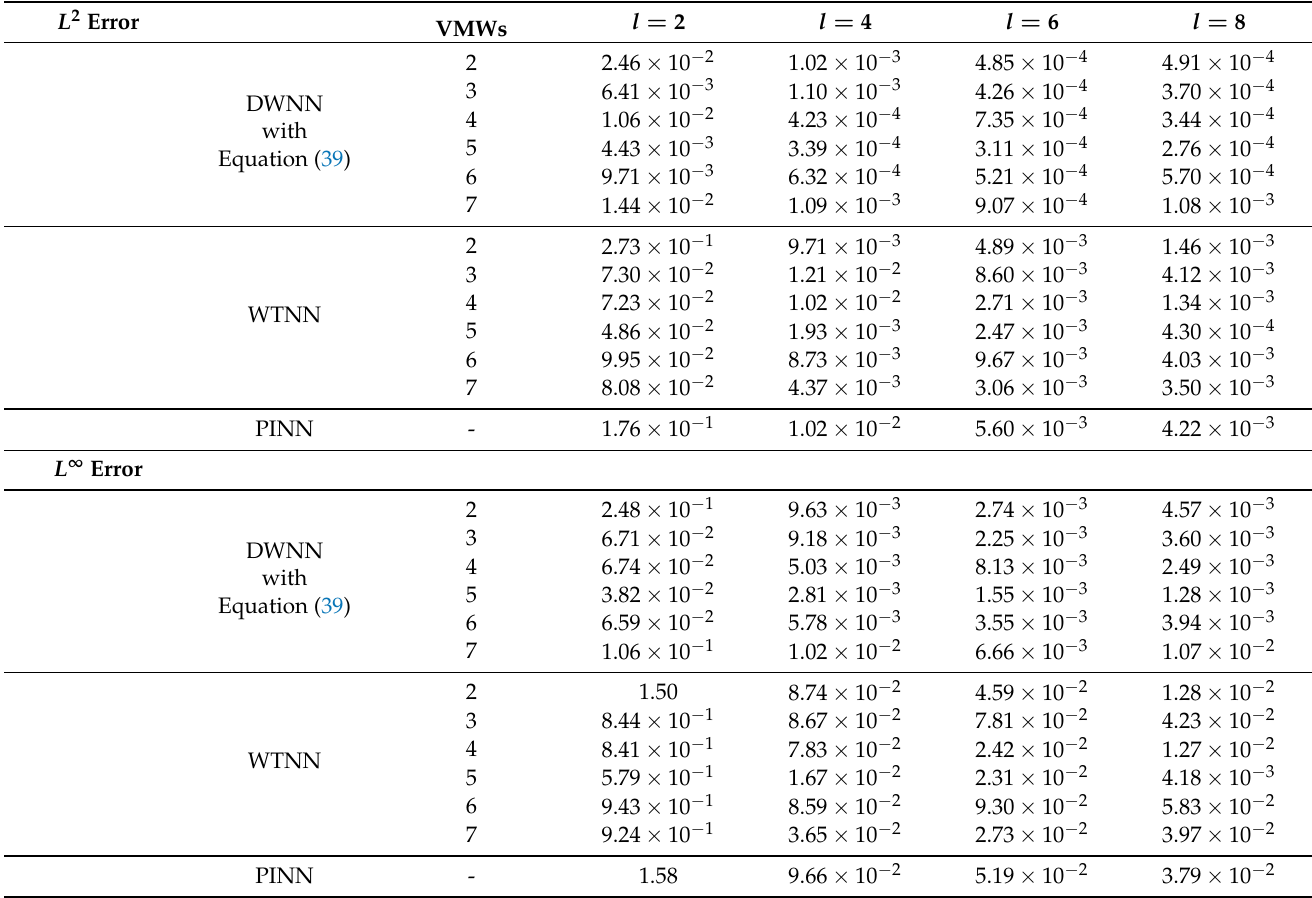
Table 5. The L 2 errors and L ∞ errors for 1D